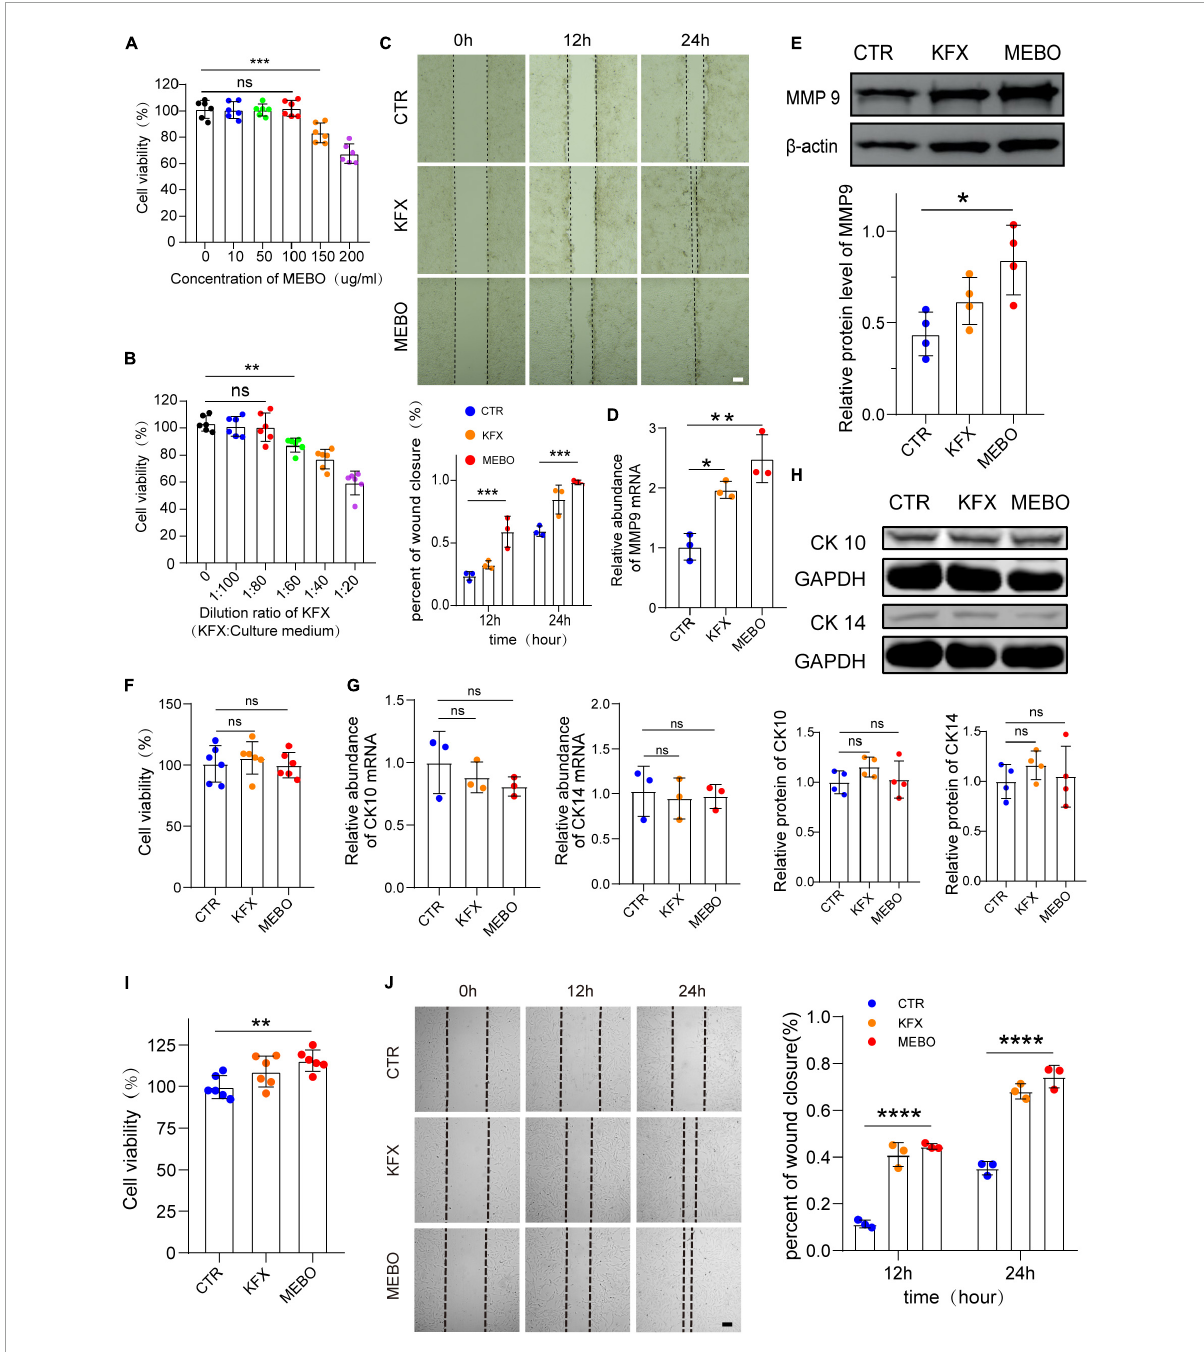
FIGURE5 MEBO accelerates the process of re-epithelialization by promoting the migration of keratinocytes. (A) The cell viability of different concentration of MEBO applied on HaCaT cells was measured by cell counting kit-8 assay. (B) The cell viability of different ratio of KFX applied on HaCaT cells were measured by cell counting kit-8 assay. (C) The representative images of wound closure of HaCaT cells at different time points in each group were taken by an inverted microscope. The scale was 100 µ m. The Percentage of wound closure of HaCaT cells at different time points in each group was statistically analyzed by ImageJ software. (D) The mRNA relative contents of MMP9 in HaCaT cells of each group were compared by RT-qPCR. (E) The protein expression of MMP9 in HaCaT cells of each group was determined by WB. β -actin serves as a loading control. The grayscale values of each strip were quantitatively analyzed by ImageJ software. (F) The cell viability of HaCaT cells in each group was determined by cell counting kit-8 assay. (G) The mRNA relative contents of CK10 and CK14 in HaCaT cells of each group were compared by RT-qPCR. (H) The protein expression of CK10 and CK14 in HaCaT cells of each group was determined by WB. GAPDH serves as a loading control. (I) The cell viability of MDF cells in each group was determined by cell counting kit-8 assay. (J) The representative images of wound closure of MDF cells at different time points in each group were taken by an inverted microscope. The scale was 100 µ m. The Percentage of wound closure of MDF cells at different time points in each group was statistically analyzed by ImageJ software. The scale was 100 µ m. All Data are shown as mean ± SD, N ≥ 3, ns P > 0.05, * P < 0.05, ** P < 0.01, *** P < 0.001, **** P <